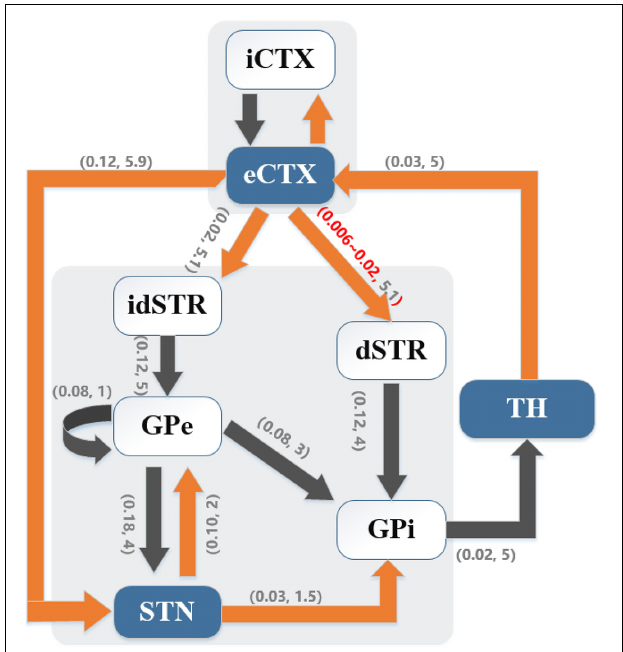
FIGURE 1 | Cortical-basal ganglia-thalamus network model. Gray blocks represent the collections of cortical (CTX) neurons and basal ganglia (BG) neurons, respectively. Model schematic shows connections within the network, where black lines denote inhibitory connections and orange lines denote excitatory connections. Here, the direct pathway (eCTX → dSTR → GPi → TH → eCTX), the indirect pathway (eCTX → idSTR → GPe → GPi → TH → eCTX) and the hyper-direct pathway (eCTX → STN → GPi → TH → eCTX) are depicted. As well, excitatory-inhibitory coupling exists between STN and GPe. Excitatory eCTX and inhibitory iCTX neurons also receive synaptic connections from each other. The numbers in parentheses on the arrows indicate the synaptic conductance (mS / cm 2 ) and transmission delay (ms), respectively.